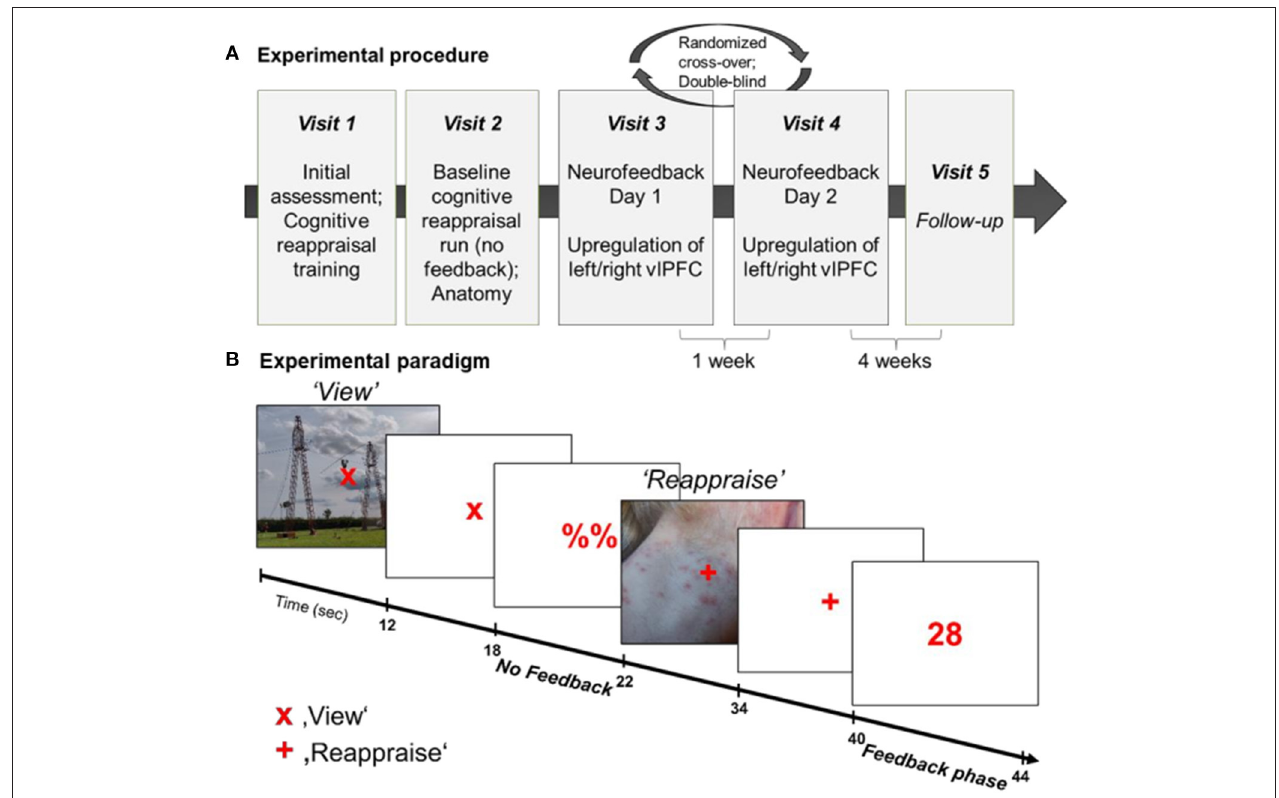
FIGURE 1 | (A) Experimental procedure. The NF training entailed 5 visits to the lab, starting with initial assessment and cognitive reappraisal training (Visit 1), followed by baseline cognitive reappraisal runs and anatomical recordings (Visit 2), two NF training days (Visit 3 and 4) and a follow-up assessment (Visit 5). (B) Experimental paradigm during NF training. All participants completed 4 NF runs on each of the two NF days. Each NF run entailed 9 view-regulate cycles. During “view” trials (“x”), participants passively viewed the picture and could allow spontaneous thoughts and emotions. On “regulate” trials (“ + ”) participants reappraised the picture to reduce the negative affect and upregulate the BOLD signal in the target area. Each picture was presented for 12s, followed by a 6-s fixation cross and 4-s (pseudo-) neurofeedback